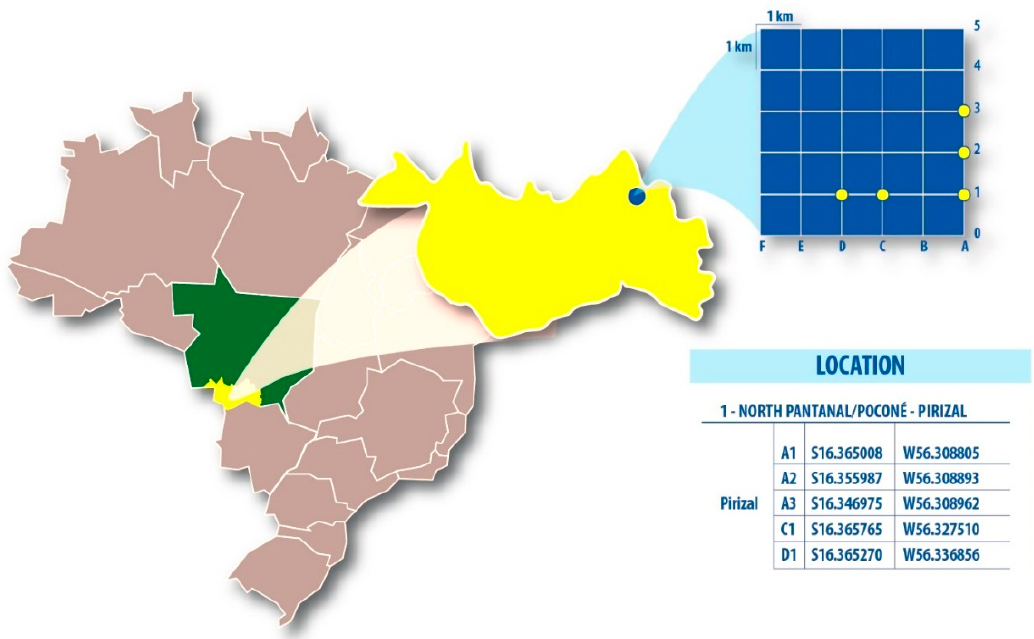
Figure 1. Rapid Assessment Program and Long Term Ecological Research system and the respective location of the five sampled grids in High Pantanal, Mato Grosso State, Central-Western